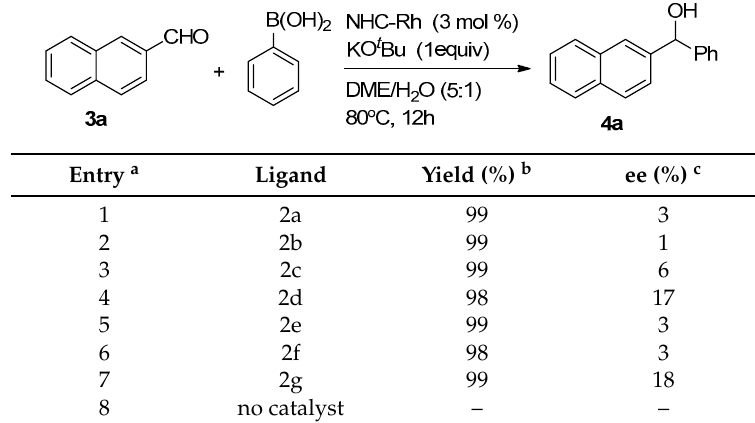
Table 1. Comparison of NHC–Rh complexes.